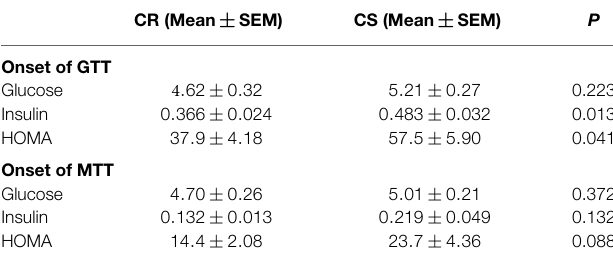
CR (final adiposity 7.22 (cid:6) 0.28%) and 10 as CS (final adiposity 11.60 (cid:6) 0.21%). MTT were performed on the 24 rats of the last three groups, among which eight were a posteriori classified as CR (final adiposity 7.00 (cid:6) 0.41%) and eight as CS (final adiposity 11.82 (cid:6) 0.60%). Insulin levels and HOMA indices were higher in CS rats ( Table 4 ) before the GTT, i.e., after 6 h fast, but not before the MTT, i.e., after an overnight fast. Figure 3 displays the glucose and insulin responses to GTT, ITT, and MTT. The decline in plasma glucose after ITT ( Figure 3C ) did not reveal differences between CR and CS rats, indicating that CS rats were not resistant to the hypoglycemic effect of insulin. Glucose and insulin levels during GTT were significantly higher in CS than in CR rats ( Figure 3A ). During MTT, only insulin levels were significantly higher ( Figure 3B ). Areas under the curve were significantly different only for the insulin response to GTT. When basal blood glucose or plasma insulin values were introduced as a covariate in the ANOVA, no more differences were observed between groups, indicating that differences during GTT and MTT were due to preexisting differences in basal glucose and insulin levels.